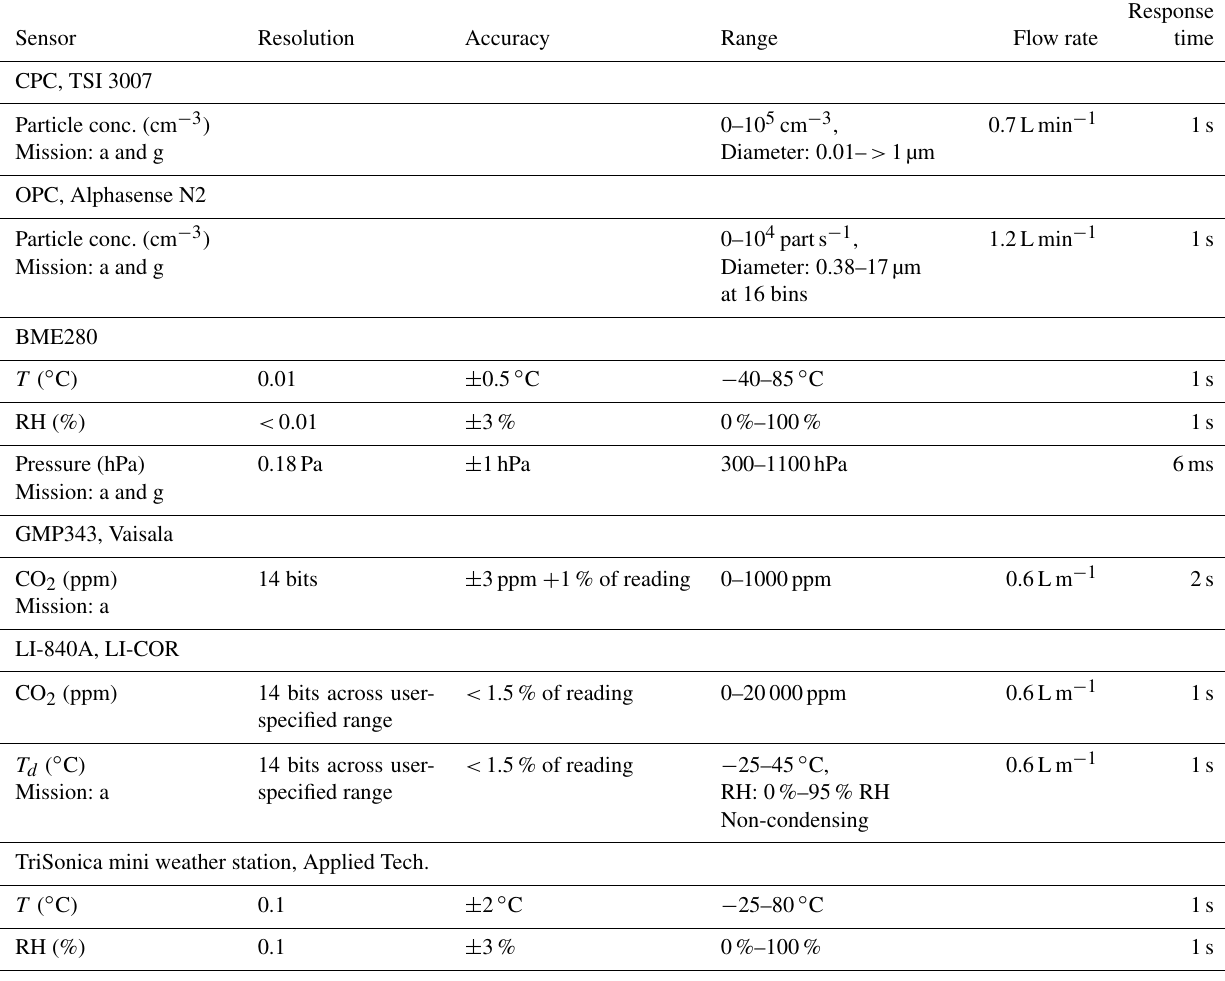
Table 1. An overview of sensors and their operational characteristics provided by manufacturer. The sensor use in airborne and/or ground- based measurements is specified in the sensor name column as mission: a – airborne and/or g –